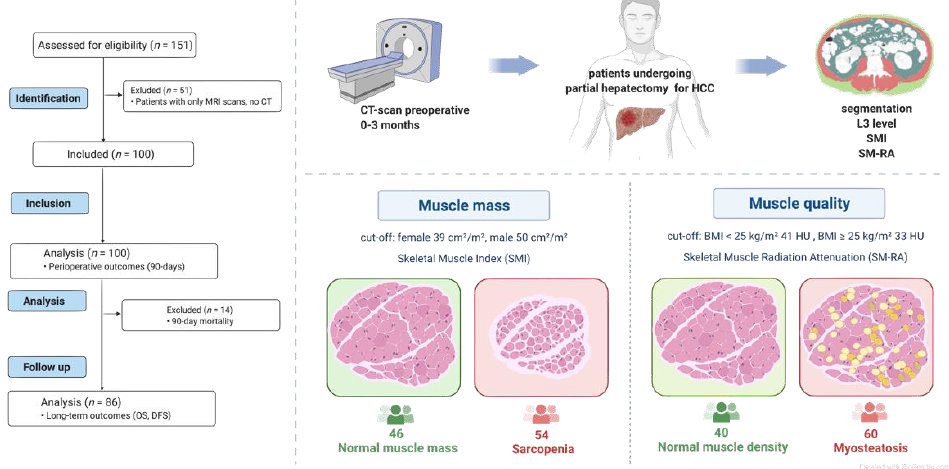
Figure 1. Study design. Patients undergoing curative-intent surgery for HCC were analysed. Sarcopenic and myosteatotic patients were identified using CT-based segmentation at the level of the third lumbar vertebra. This figure was created with BioRender.com. Abbreviations used: MRI: magnetic resonance imaging; OS: overall survival; DFS: disease-free survival; CT: computed tomography; HCC: hepatocellular carcinoma; L3: third lumbar vertebrae; BMI: body mass index; HU: hounsfield units; SMI: skeletal muscle index; SM-RA: skeletal muscle radiation attenuation.